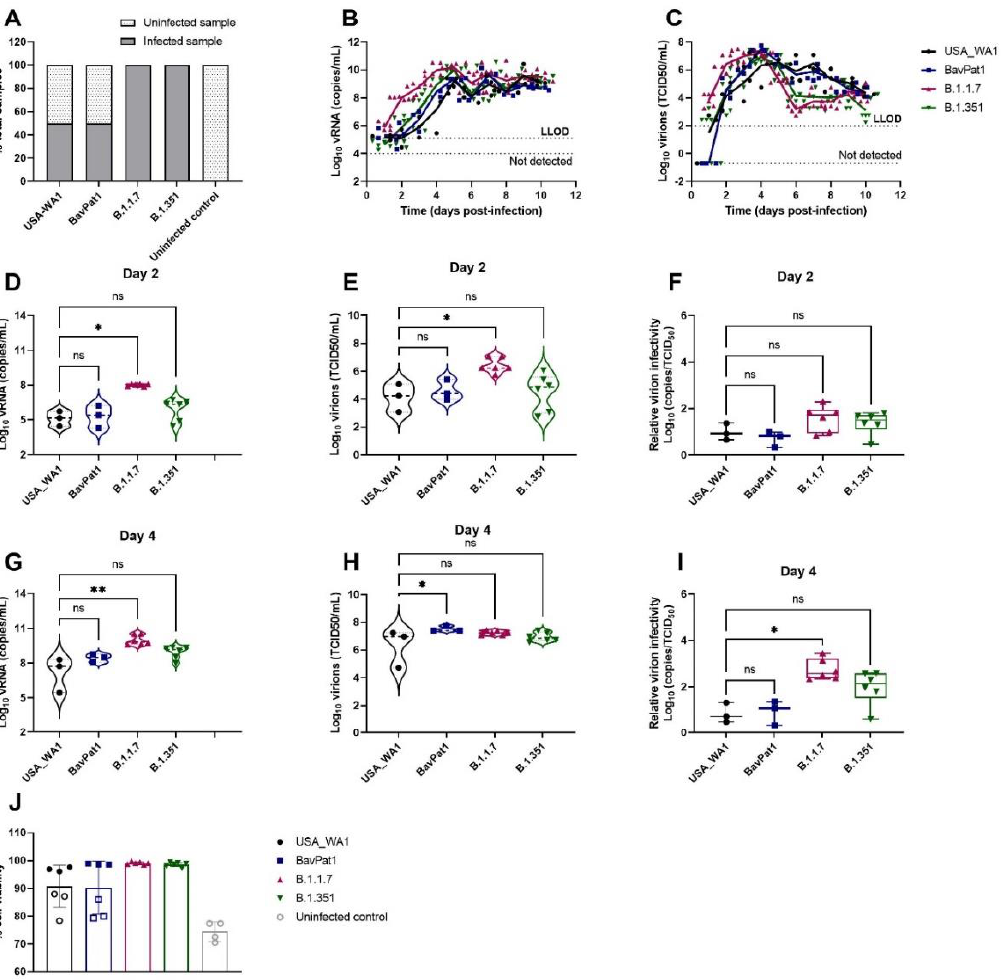
Figure 2. SARS-CoV-2 VoC replication kinetics in human bronchial airway epithelial cell cultures. Viral replication of SARS-CoV-2 VoC at the viral input of 2 × 10 3 TCID 50 /insert in HbAEC cultures. The cultures were incubated at 35 °C and maintained for 10 days. ( A ) Percentages of infected cul- tures in total tested samples. Six independent inserts were used for each infected condition while only four inserts were used for non-infected control group. ( B , D , G ) Viral RNA or ( C , E , H ) infectious particles in apical washes of infected cultures were determined by RT-qPCR or by end-point titra- tions, respectively. ( F , I ) Relative virion infectivity. ( J ) Cell viability of HbAEC cultures. Infected samples were represented as filled markers whereas non-infected samples were indicated as open markers. Dots represent individual samples. The dotted lines indicate the lower limit of detection (LLOD). ns p > 0.05, * p < 0.05, ** p < 0.01. To further comprehend the immune response of the HAEC towards SARS-CoV-2 in- fection, the expression levels of cytokines related to COVID-19 in patients were analyzed in the apical washes of the cultures. Only for the B.1.351 and B.1.1.7 isolates we could see a difference in cytokine production compared to the uninfected controls. In the B.1.351- infected group, an upregulation of IP-10 levels of 5.5 fold ( p = 0.0044; Figure 3A) to 7.5 fold ( p = 0.0004; Figure 4A) compared to the uninfected group was observed at 6 days p .i. A 4.6-fold increase in IP-10 expression was induced by the B.1.1.7 variant on day 4 p.i. ( p = 0.0114; Figure 4A). No upregulation in IL-6 production was observed (Figure 3B, Figure 4B). Likewise, no difference in other cytokine levels (i.e., IL-10, IFN- ɣ , TNF- α) was noted (data not shown). The overall discrepancy in cytokine production between the alpha and beta variants versus basal strains was limited.